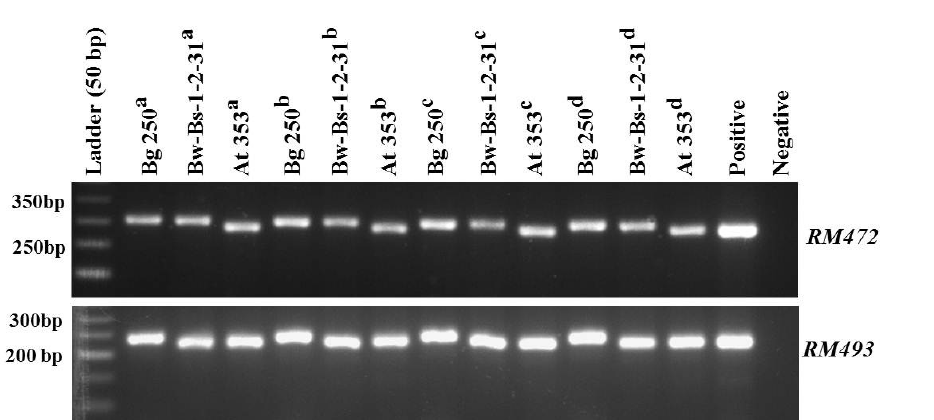
Figure 2: Composite agarose gel image of the simplex PCR for RM472 and RM493 markers (2.5% agarose gel electrophoresis). The names of the microsatellite markers are indicated on the right side of the Figure and the key band sizes of the ladder are indicated on the left side. The 50bp ladder was used as the size standard. Names of the rice varieties/lines are given on the top. a: CTAB method, b: modified CTAB method, c: Promega kit, d: Qiagen